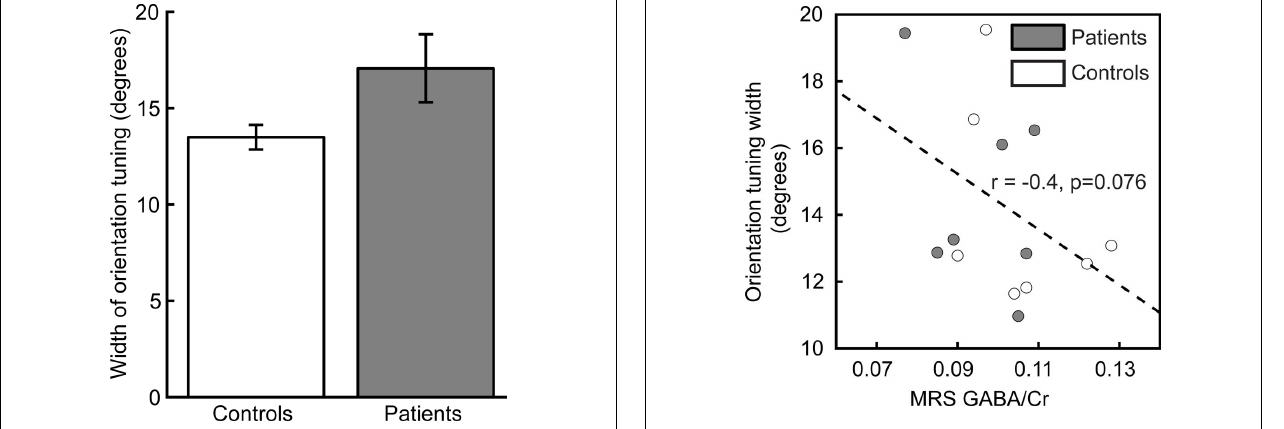
FIGURE 3 |Width of orientation tuning as estimated by Gaussian fit. Patients had broader mean orientation tuning than controls ( p < 0.05). Error bars indicate SEM for each group.